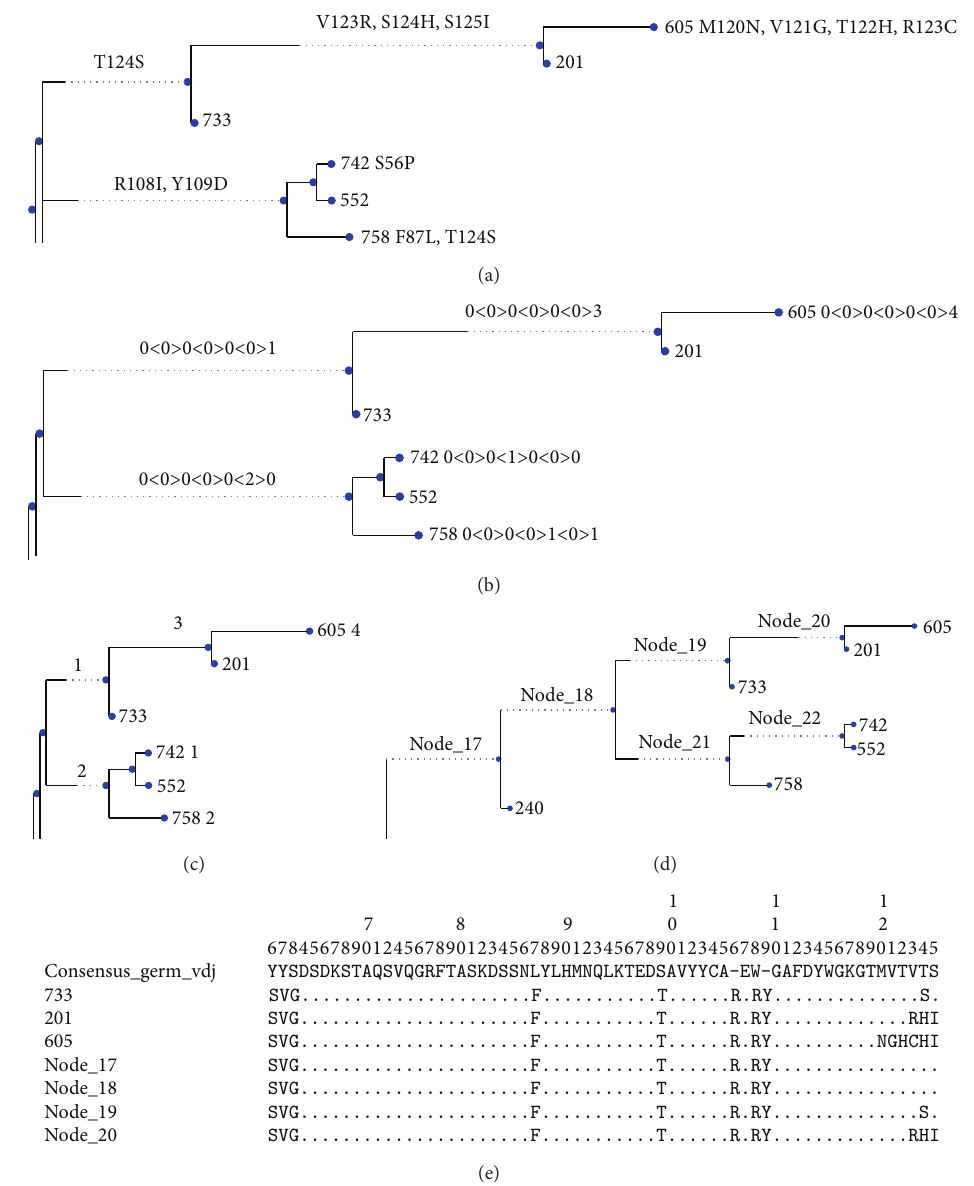
Figure 2: Sample output from AnnotateTree. The samples are taken from the zebrafish repertoire described in more detail in Results and Discussion.(a)AnnotationwithAAsubstitutions,usingIMGTstandardnumbering.(b)Summaryannotationshowingacountofthenumber of AA substitutions in each FR and CDR using the convention FR1 < CDR1 > FR2 < CDR2 > FR3 < CDR3 > FR4. (c) Annotation showing the total number of AA substitutions on each branch. (d) Tree showing the location of each inferred ancestral node, for cross-reference against AA and nt alignments. (e) Extract from the AA alignment, showing selected nodes from the above